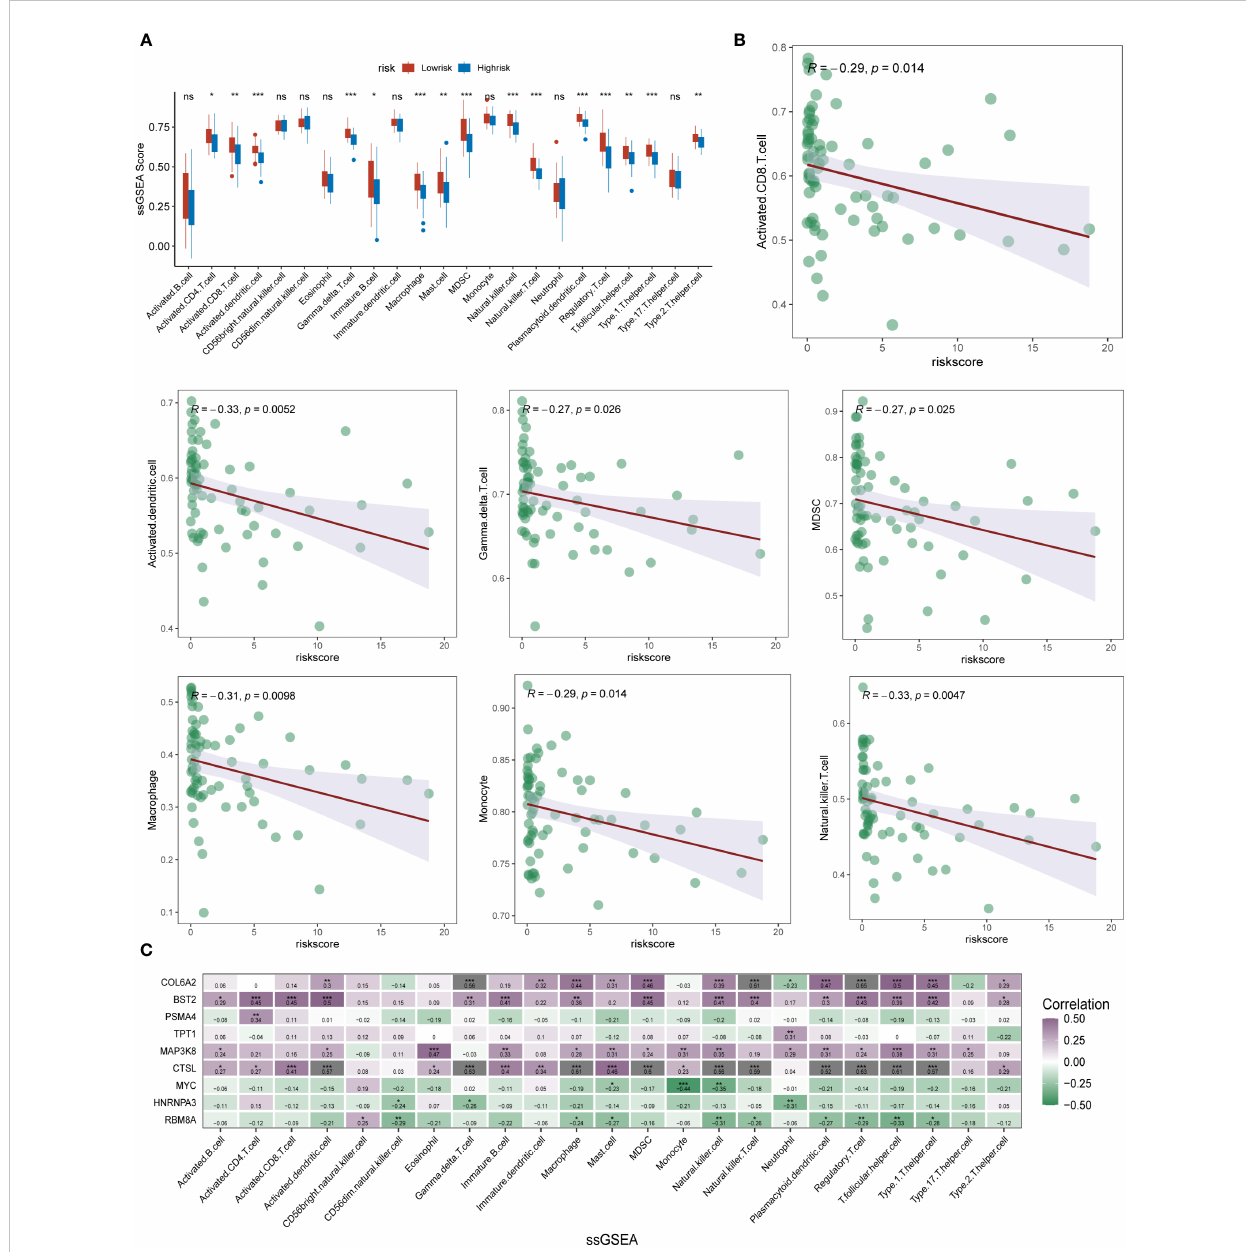
FIGURE 5 ssGSEA analysis of immune in fi ltration and cell expression annotation in ESCC patients. (A) Box plot format analyzing the differential expression of multiple immune cells and immune-related proteins in the m6A high-risk and low-risk groups. The expression of several types of immune cells, including activated CD8 T cells, MDSC, gama delta T cells, activated dendritic cells, NK T cells, macrophages, and Monocyte, differed signi fi cantly between subgroups, and the m6A epistasis The expression levels of these immune cell types were signi fi cantly higher in the low-risk group than in the high-risk group; (B) Linear correlation plots assessed the expression correlations between multiple immune cell types and the riskscore; (C) Correlational heat map analysis further clari fi ed the correlation between multiple immune cells and immune in fi ltration levels and the expression of each speci fi c gene in the m6A risk model (shades of colour indicate the level of correlation, purple indicates positive correlation, blue indicates negative correlation). * means <0.05, ** means <0.01, *** means <0.001, ns means